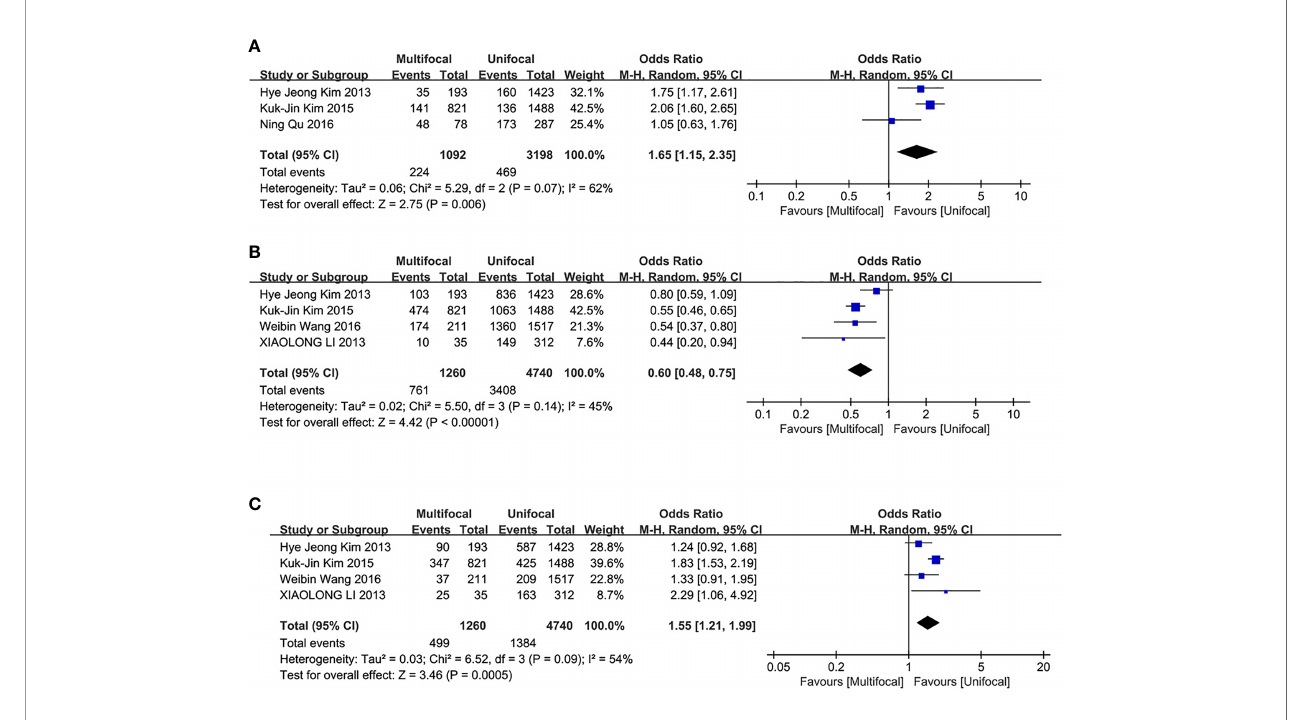
FIGURE 4 | Meta-analysis results for the difference between the UMPTC and UUPTC. (A) LLNM; (B) TNM stage I+II; (C) TNM stage III+IV.